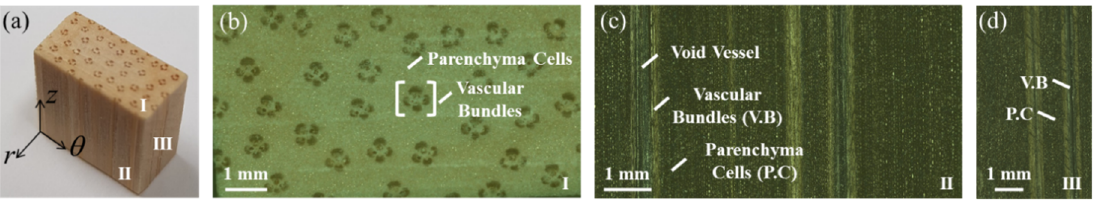
Figure 1. ( a ) Cuboid representation of middle-section, across wall thickness of bamboo culm; ( b ) radial-tangential optical image of bamboo cross-section; ( c ) longitudinal-tangential laser-optical image and ( d ) longitudinal-radial laser-optical image of bamboo longitudinal section. Figure 1b–d were taken by a Keyence VK-X200 series Laser Microscope (Keyence, Osaka, Japan).